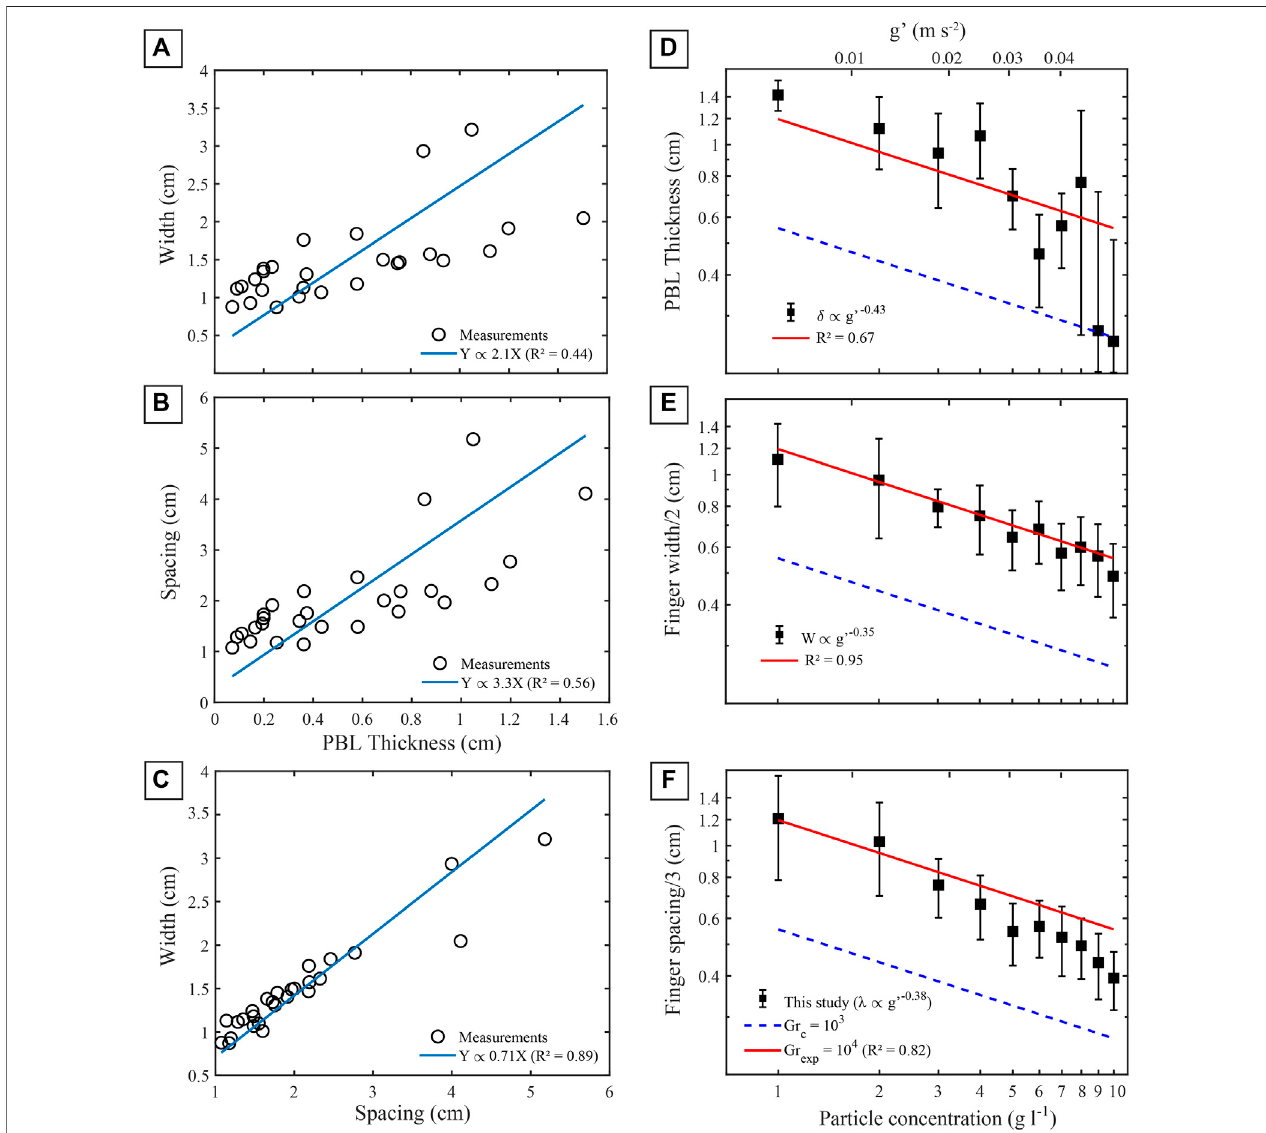
FIGURE10| Comparisonbetween fi ngerscharacteristiclengthsforindividualexperiments. (A) Width( W )asafunctionofPBLthickness( δ ). (B) Spacing( λ )against PBL thickness (C) Width against spacing. The blue lines show the proportionality relationships inferred between characteristic lengths: W (cid:2) 2.1 δ ; λ (cid:2) 3.3 δ ; W (cid:2) 0.71 λ . ( D – F ) Log-log plot of the characteristic length scales of the instabilities, measured 10 to 20 s after the beginning of the experiment, including (D) PBL thickness δ , (E) fi nger width W and (F) fi ngerspacing λ ,asfunctionsofinitialparticleconcentration,comparedtothepredictionofHoyaletal.(1999b).Thebluedashedlinecorrespondsto Gr c (cid:2) 10 3 and the red solid line to Gr exp (cid:2) 10 4 . Vertical error bars correspond to the standard deviation of the sizes measured in different experiments.